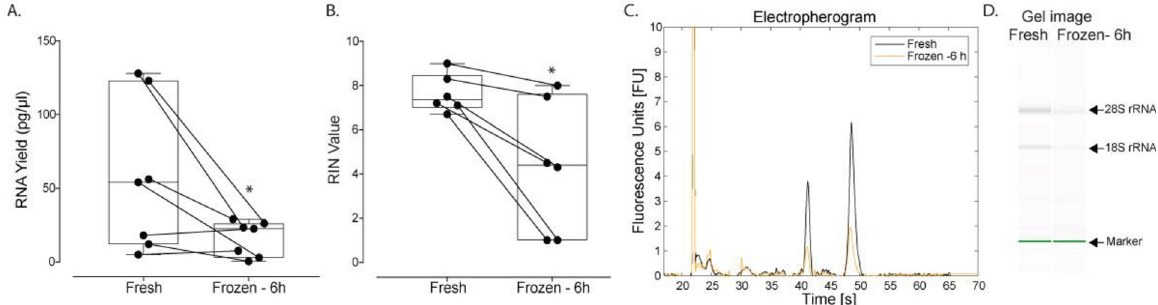
Fig 4. Impact of freeze-thaw on RNA yield of plasma-derived EVs. In all cases, cryovials were first placed in a Nalgene freezing container before adding to the -80˚C freezer and thawed in a warm water bath. RNA was extracted using RNeasy spin columns. (A) RNA yield and (B) RIN of plasma-derived EVs in frozen/thawed (samples were held at -80˚C for 6 hours) versus control (fresh) samples are expressed as box-and-whiskers plots showing median, interquartile range, maxima/minima, and all individual data points (n = 7). (C) A representative electropherogram and (D) gel image showing RNA traces obtained from the Bioanalyzer. Data were analyzed using the Wilcoxon signed-rank test (p < 0.05); an asterisk indicates statistical significance. Fresh (black) versus Frozen (yellow) denotes control (not frozen) versus samples frozen and thawed with a freezing bucket and rapidly warmed in a water bath,